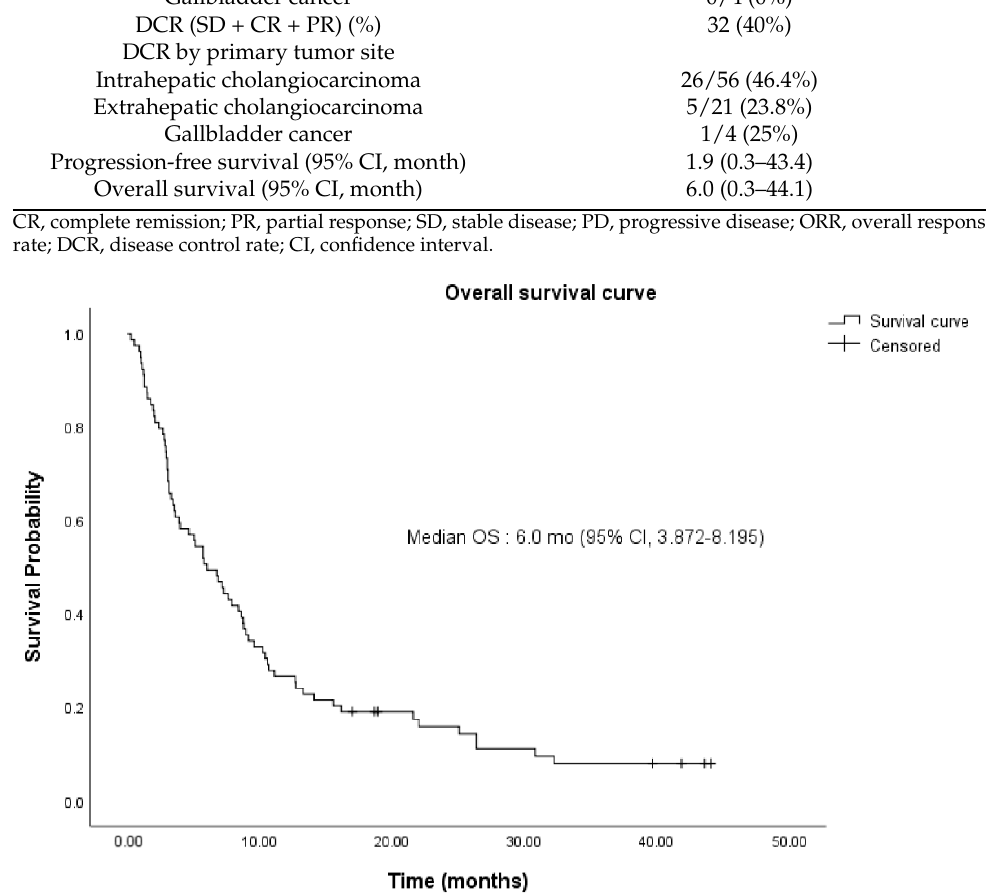
Figure 3. Kaplan–Meier estimates of the progression-free survival (PFS) of the entire study popula- tion (n = 80). Median PFS was 1.9 (95% CI, 1.822–1.978) months. PFS, progression-free survival; mo, month; CI, confidence interval. The results of the univariate and multivariate Cox analysis to identify the factors af- fecting the OS of patients treated with pembrolizumab are summarized in Table 3. The OS was significantly correlated with the tumor burden (TB; p = 0.010), albumin levels ( p < 0.001), alkaline phosphatase (ALP) levels ( p = 0.066), lymphocyte-to-monocyte ratio (LMR; p = 0.003), neutrophil-to-lymphocyte ratio ( p < 0.001), platelet-to-lymphocyte ratio (PLR; p < 0.001), and carbohydrate antigen (CA)-19-9 levels ( p = 0.022). The multivariate Cox